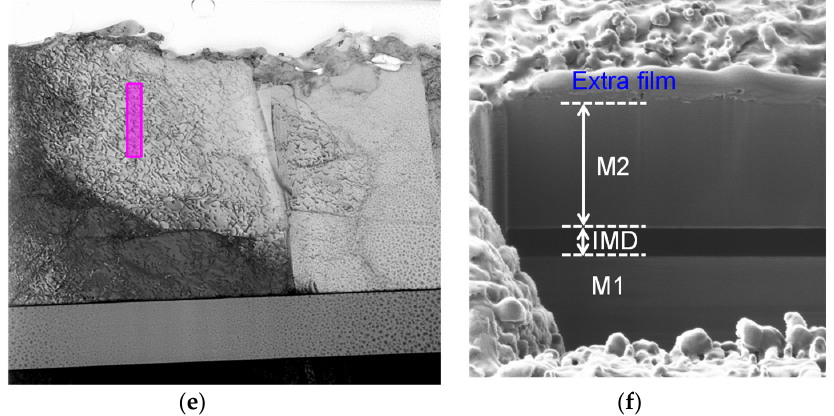
Figure 7. Zoomed − in view of the damage sites at regions ( a ) 1, ( b ) 2, ( c ) 3, and ( d ) 4 in Figure 6b, where are all at the corner regions of the pads facing each other (arrows) ( e ) the top view SEM picture of the pads in the test line in Figure 7a ( f ). TEM picture for the layers below the pink region are shown in ( e ).